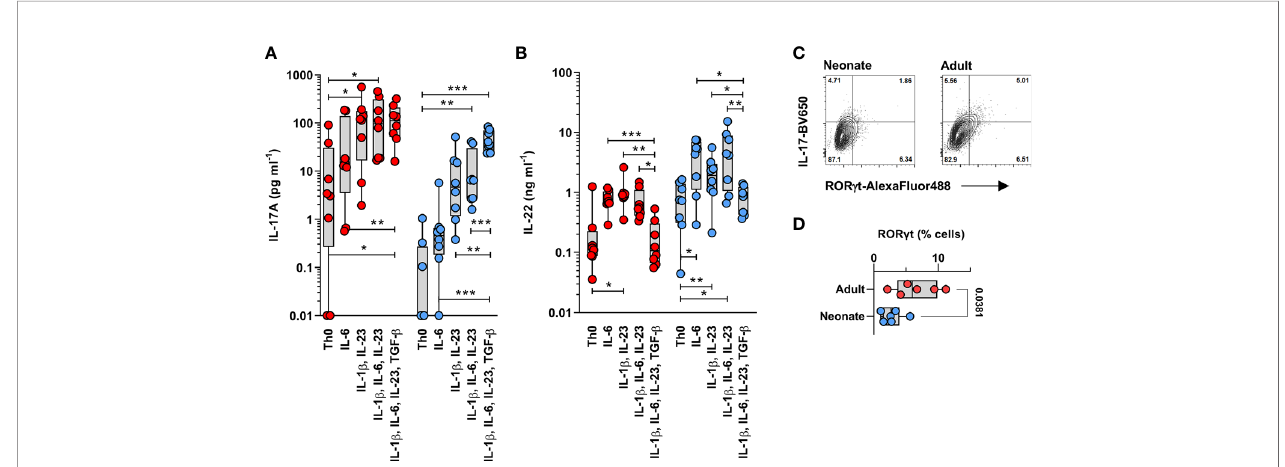
FIGURE 4 | Neonatal T cells are skewed towards high IL-22 production and differ from adult T cells in their TGF- b during Th17 cell differentiation. IL-17 (A) and IL-22 (B) were measured in adult (red) and neonatal (blue) magnetic bead-isolated naïve CD4 T cells stimulated using anti-CD3/CD28 beads for 6 days in the presence of the indicated cytokine combinations. Data are combined from 8 separate experiments using cells from different subjects per age group, with cytokines measured in a single batch/assay; undetectable cytokines are shown as 0.01 pg ml -1 ; IL-17 (A) and IL-22 (B) production were signi fi cantly different between neonatal and adult T cells, as assessed using a 2-way ANOVA (age effects: p =0.023 for IL-17 and p =0.002 for IL-22); where statistical signi fi cance for the differences in cytokine stimulation conditions within age groups are shown after adjusting for multiple comparisons using a 5% false-discovery rate; *p < 0.05; **p < 0.01; ***p < 0.001; (C) Representative gating (on live cells) of ROR g t expression in IL-17-producing cells from neonatal and adult naïve CD4 T cells differentiated for 6 days in the presence of IL-1 b , IL-6, IL-23 and TGF- b , followed by a 5-hour PMA/Ionomycin stimulation (to bring up IL-17 expression), and (D) cumulative data from 6 independent neonatal and adult T cell